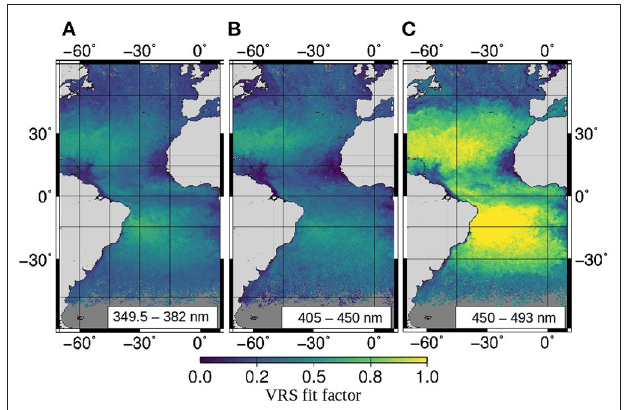
FIGURE 5 | TROPOMI (A) K d -UVAB, (B) K d -UVA, and (C) K d -blue in the Atlantic Ocean gridded at 0.083 ◦ as mean for 11 May to 9 June 2018. Accordingly, K d -UVAB, K d -UVA, and K d -blue measured in-situ at 19 stations during expedition PS113 are overlayed as diamonds (match-ups) and circles (unmatched stations). (C) White stars mark the location of the Triaxus transects for which match-ups were found.